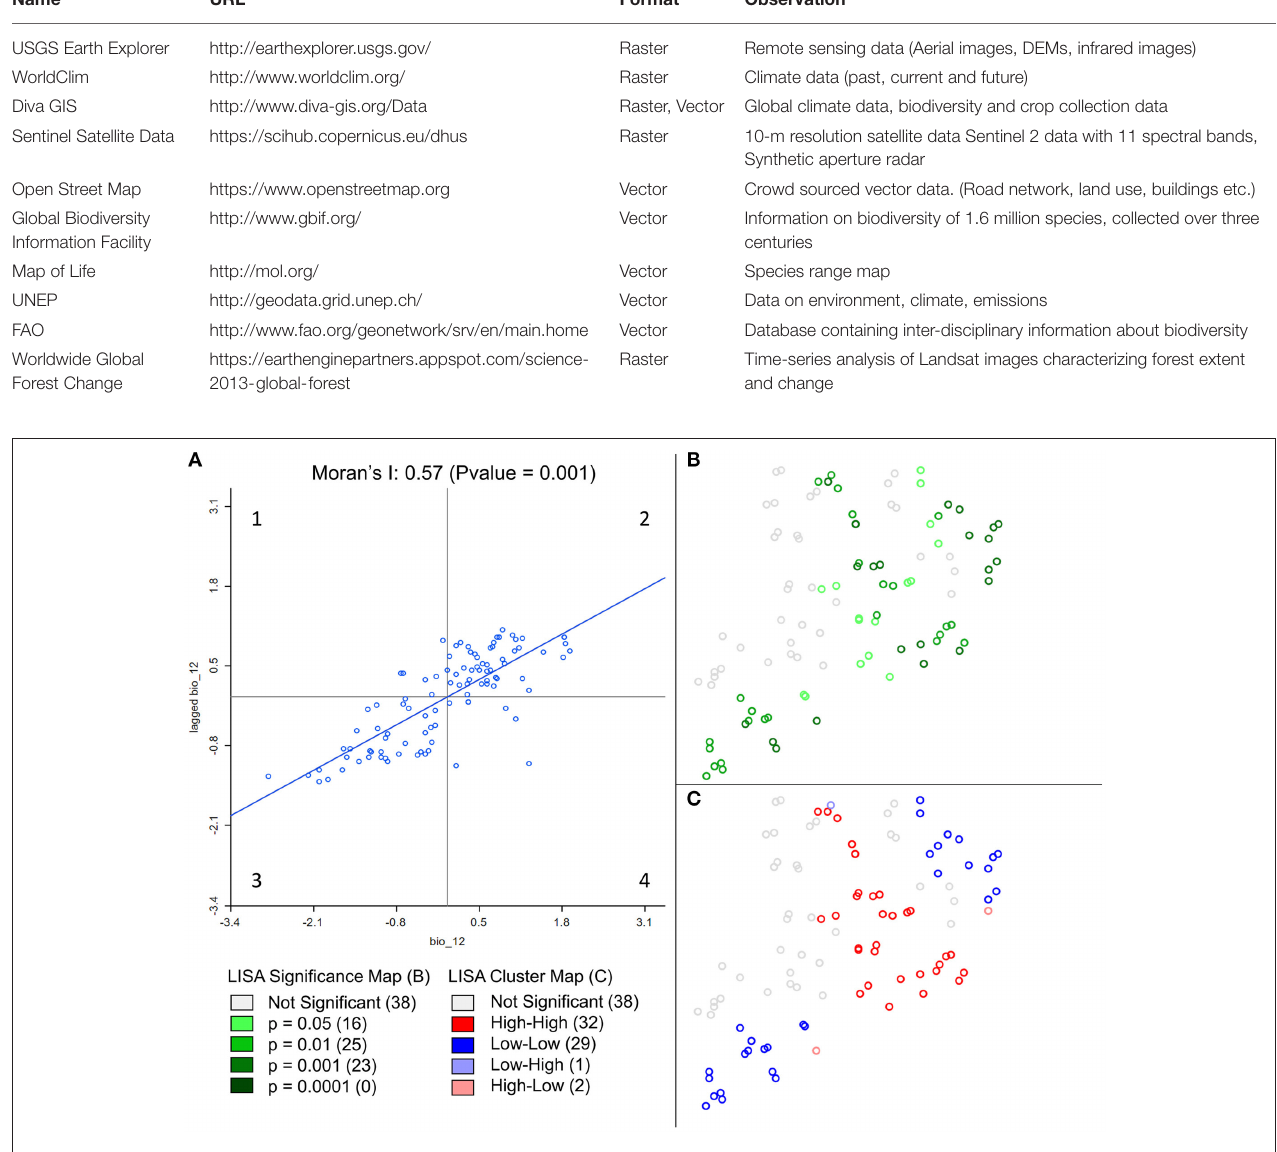
FIGURE 1 | Example of spatial statistic measurement in GeoDa. Results from global and local spatial autocorrelation (SA) were computed on Annual Precipitation at sampling locations of Ugandan cattle (Stucki, 2014). Annual Precipitation was extracted from the WorldClim dataset. In GeoDa, a weight file was created using the 10 nearest neighbors before computing spatial autocorrelation. Nine hundred ninety-nine permutations were performed to assess the significance of both SA measurements. The scatter plot of Global SA (A) , measured by the slope of the regression (0.57) displays the standardized precipitation values of each point on the X axis and standardized mean precipitation values of their 10 nearest neighbors on the Y axis. The scatterplot shows a positive correlation between most individuals and their neighbors. In other words, when precipitation is high (low) at a given location, close surrounding locations are more likely to experience high (low) precipitation as well. This positive correlation between neighboring locations is the translation of a clustering of values. On the other hand, significant local SA coefficients (B) are categorized (C) according to the 4 quadrants of the Moran’s I plot (A) . In contrary to global SA, local SA indicates the location of positive SA or clustering (High-High–A2, Low-Low–A3), and negative SA or spatial outliers (High-Low–A1, Low-High–A4). Non-significant local SA coefficients are displayed in white.